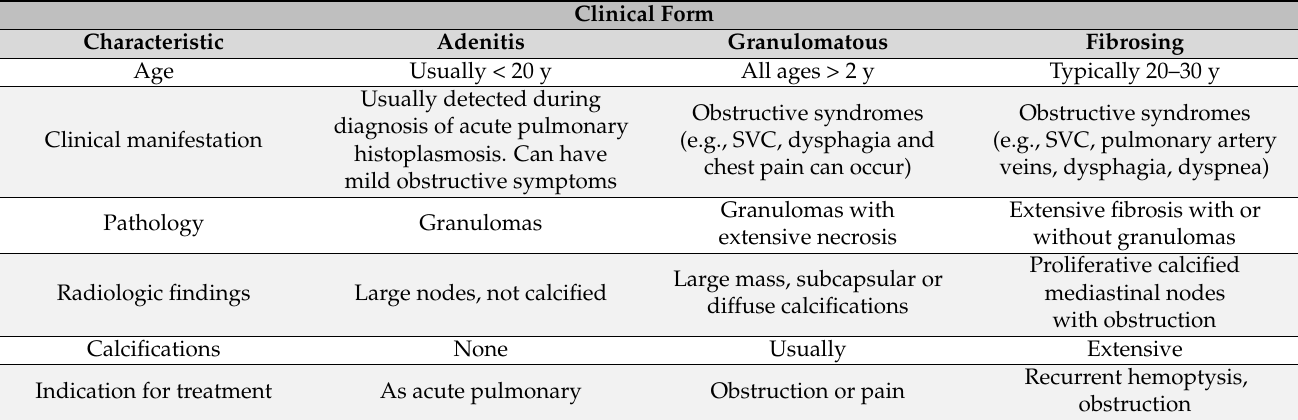
Table 4. Key features of mediastinal